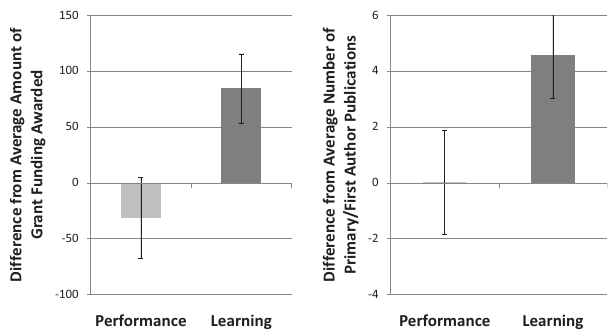
FIG. 1. Effect of learning and performance orientations on grant funding and primary and/or first-author publications for practicing physicists and chemists while controlling for gender, race and/or ethnicity, field, current position, type of institution, and years in current position. Error bars represent (cid:4) 1 standard